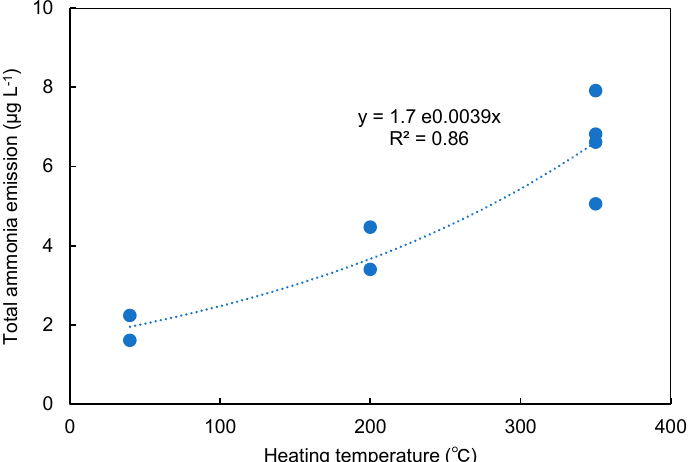
Figure 4. The relationship between the total emission amount of ammonia and the heating temperature of devices used in this study. Single exponential regression analysis; y = 1.7e 0.0039x , r 2 = 0.86.